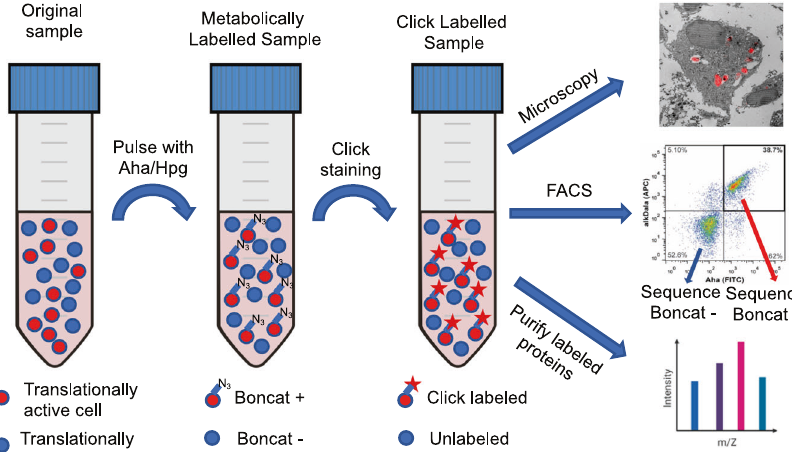
Fig. 4 Schematic of a standard BONCAT work fl ow. In vivo or in vitro samples that vary in translational activity are pulsed with a biorthogonal methionine analog (Aha or Hpg), after which they are labeled for downstream analysis using any type of microscopy, such as the correlative light-electron microscopy of a click-labelled Salmonella typhimurium inside a macrophage imaged here [84]; by cell sorting (a mixture of dual cell wall/proteome labeled M. tuberculosis and unlabeled cells is shown here) [95]; or mass spectrometry for expressed proteome